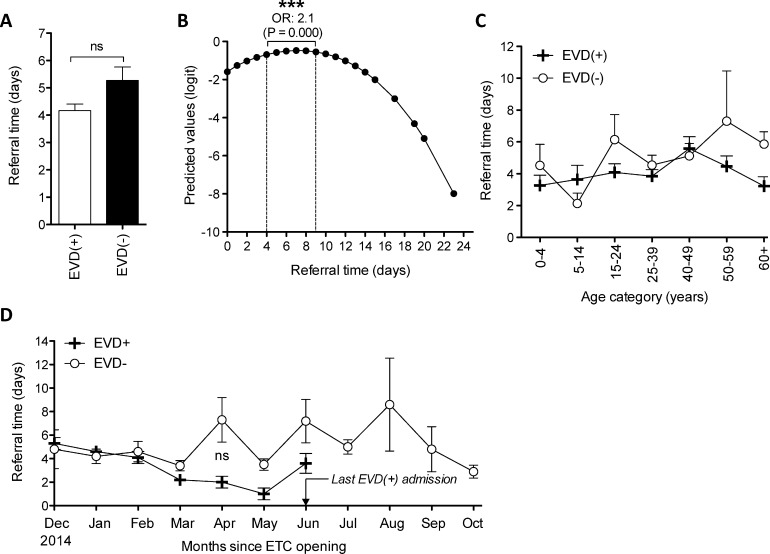
Impact of EVD on referral sensitivity.(A) Mean referral time (days since symptom onset at triage) for EVD(+) and EVD(-) cohorts. (B) Fitted relationship between referral time and outcome using fractional polynomial analysis [25]. (C) Mean referral time for EVD(+) and EVD(-) patients according to age categorisation. (D) Mean referral time for EVD(-) and EVD(+) patients over the entire time course of the study (December 2014 to October 2015). *: p<0.05, **: p<0.005, ***: p<0.001, ns: not significant, ETC: Ebola Treatment Centre.